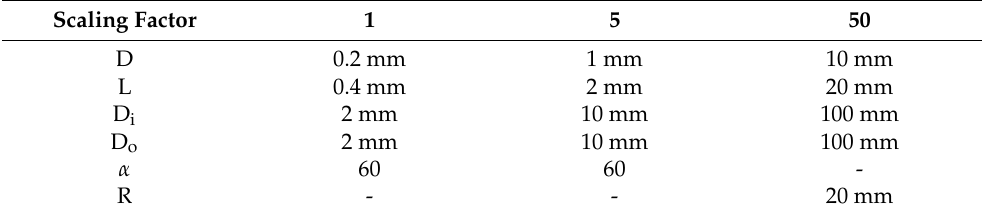
Figure 1. ( a ): Sketch of the orifice in scale M50; ( b ): Sketch of the orifice in the original scale M1 and the meso scale. Variables and the coordinate system are displayed. The indicated capillary is only present in scale M5. Table 1. Comparison of the different lengths of the orifice in the different scales.